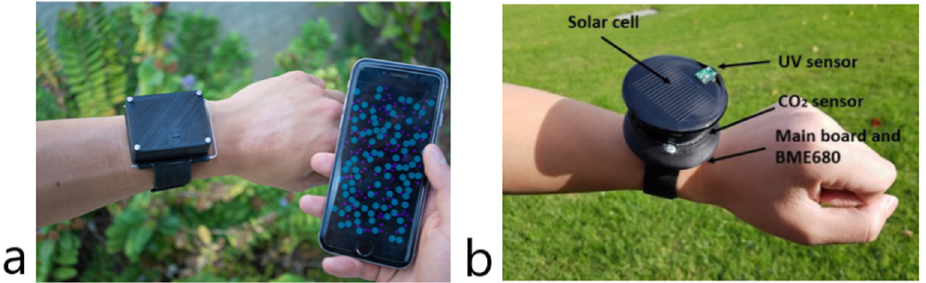
Figure 3. Wrist-worn wearable environmental monitors from the analyzed research papers: ( a ) Mypart; and ( b ) We-safe.